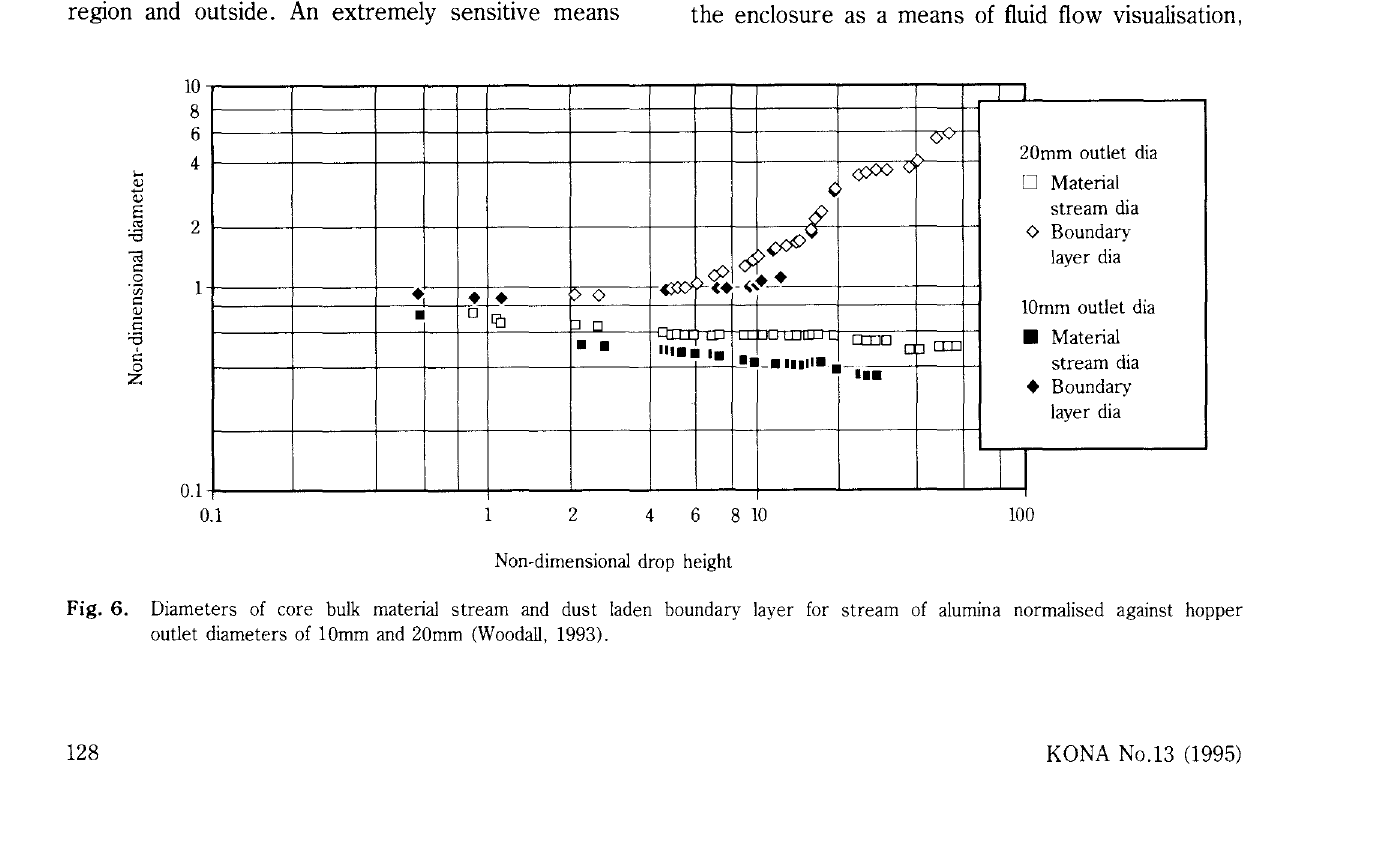
Fig. 6. Diameters of core bulk material stream and dust laden boundary layer for stream of alumina normalised against hopper outlet diameters of lOmm and 20mm (Woodall,